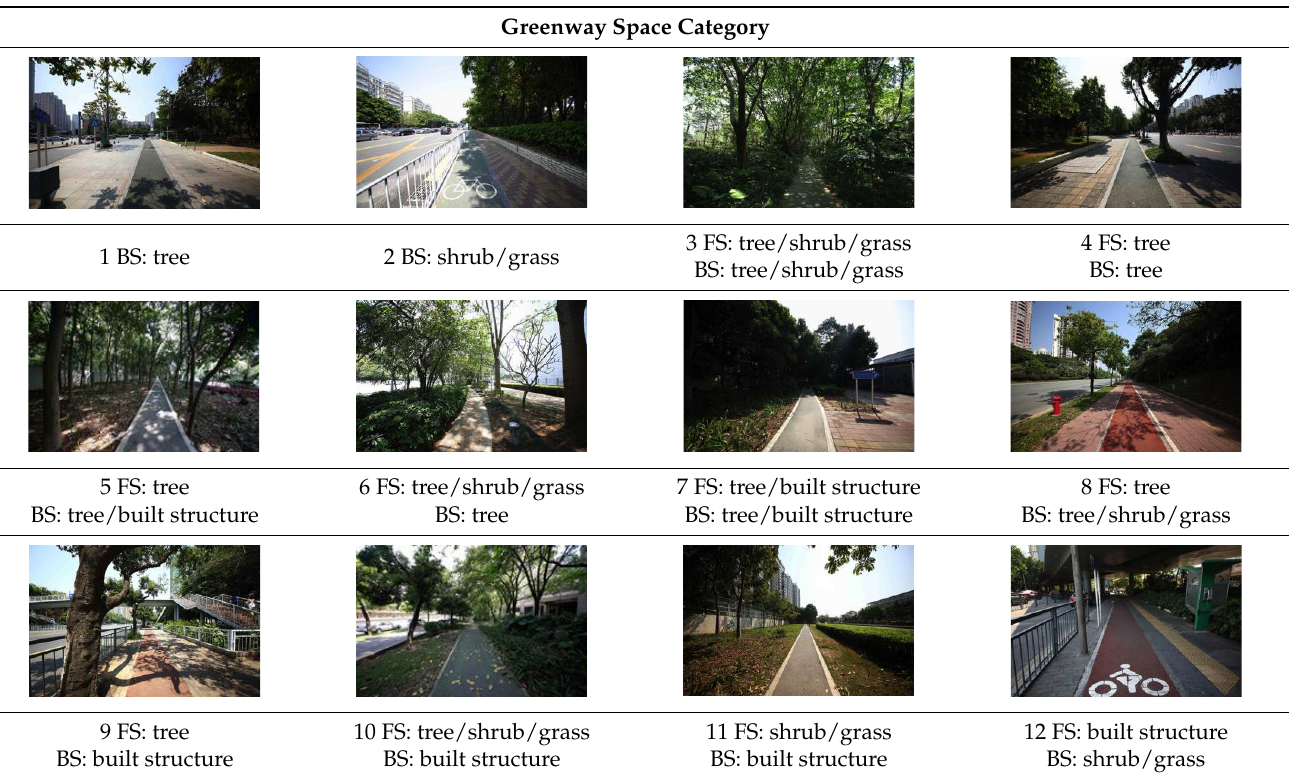
Table 1. SZ greenway space categories.